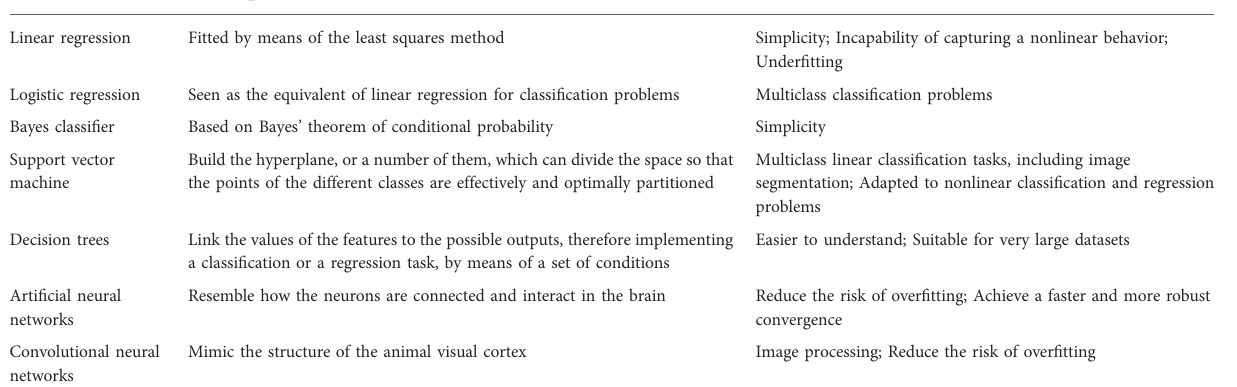
TABLE 1 The methods used for machine